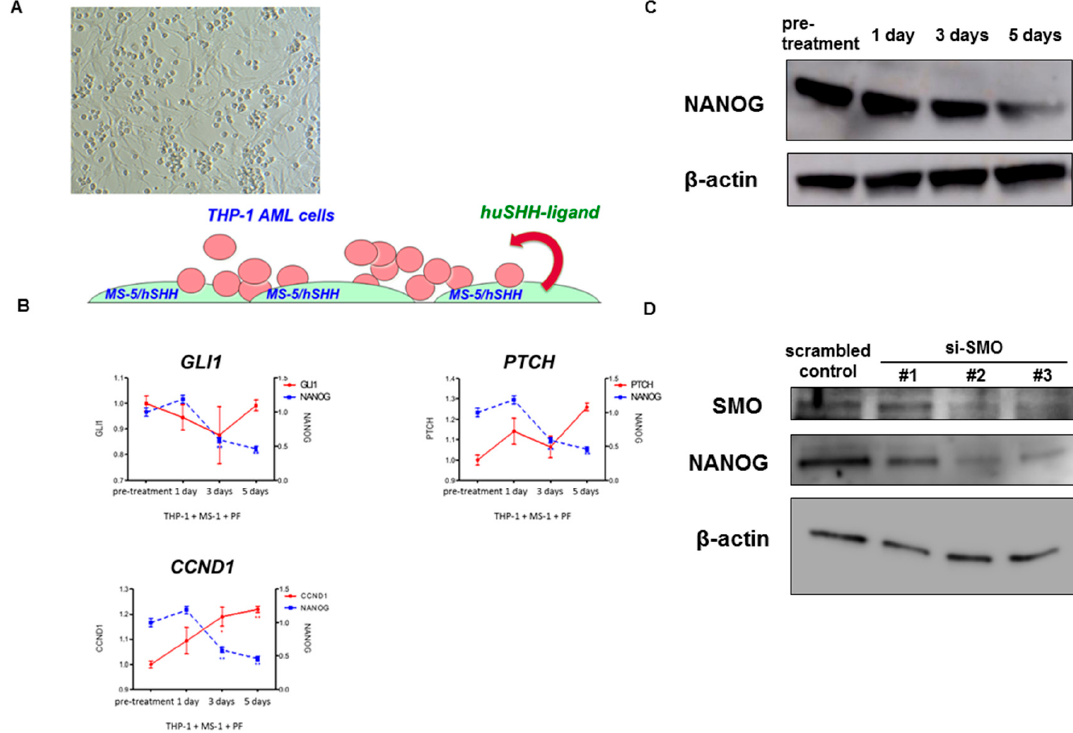
Figure 3. Inhibiting SMO pharmacologically and genetically leads to dysregulation of NANOG expression in vitro model. ( A ) A co-culture model of an AML cell line (THP-1) with stroma which overexpresses human sonic hedgehog (SHH) ligands; ( B ) NANOG transcripts substantially decreased during PF-913 treatment in THP-1 cells co-cultured with MS-5 cells over-expressing human SHH ligands. In a pre-clinical setting, although the level of GLI-target gene transcript did not decrease much, that of NANOG decreased during the time course; ( C ) Western blotting showed the NANOG protein level decreased during PF-913 treatment; ( D ) Western blot analysis showed downregulated NANOG protein after transfection with SMO siRNAs in comparison to cells transfected with scrambled control. Although knockdown effect of SMO by si-SMO#1 was weak compared with #2 or #3, NANOG expression was evident as well.